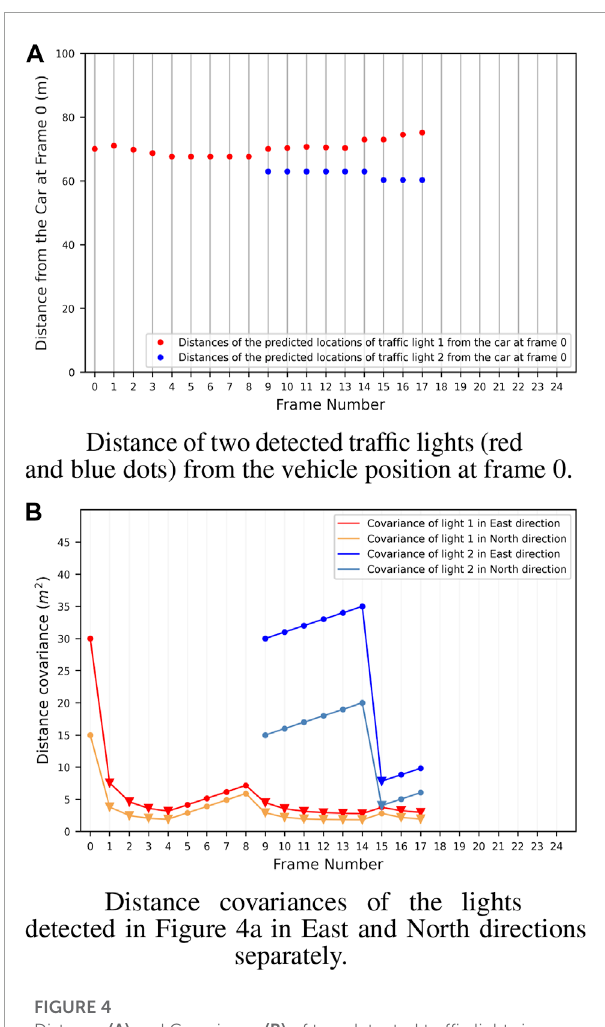
FIGURE 4 Distance (A) and Covariance (B) of two detected traffic lights in a sequence of 18 frames from the DTLD. It is interesting to notice how the covariance rapidly decrease when a new detection is performed. In particular the red light is detected many times and the covariance always maintain low values. Differently, the blue one is detected only at frame 9 and 15, therefore the covariance has only one drop when the new detection is